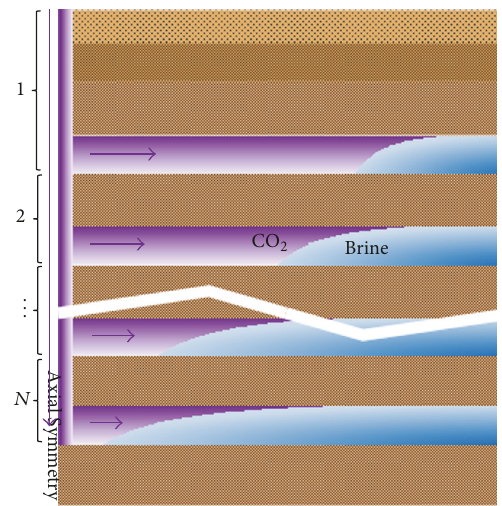
Figure 1: Schematic of the injection well and its related